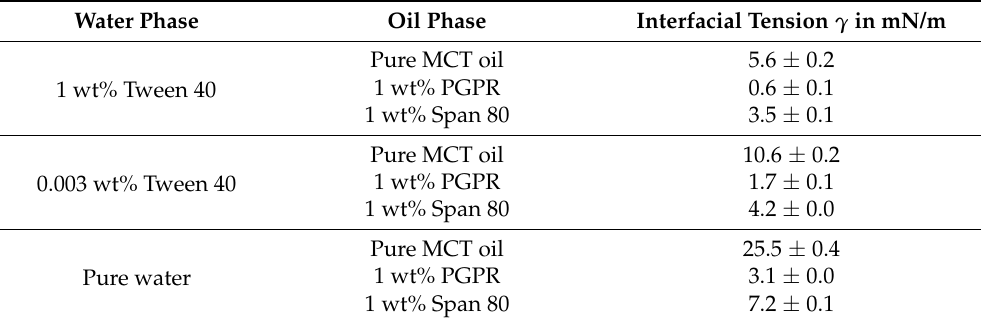
Table 1. Interfacial tensions of systems with different combinations of water and oil phase after 60 min equilibration time. The nine surfactant combinations shown here are used for all experiments. Water Phase Oil Phase Interfacial Tension γ in